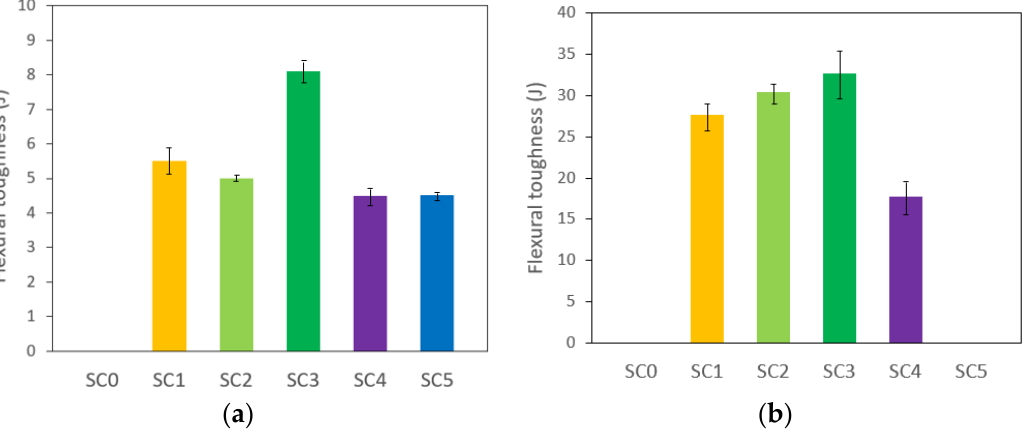
Figure 9. Flexural toughness of MFRCM and HyFRCM; ( a ) when the deflection is L/600 (0.5 mm), and ( b ) when the deflection is L/150 (2.0 mm).